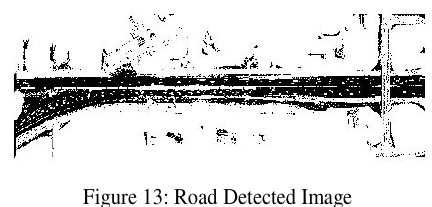
Figure 13: Road Detected Image